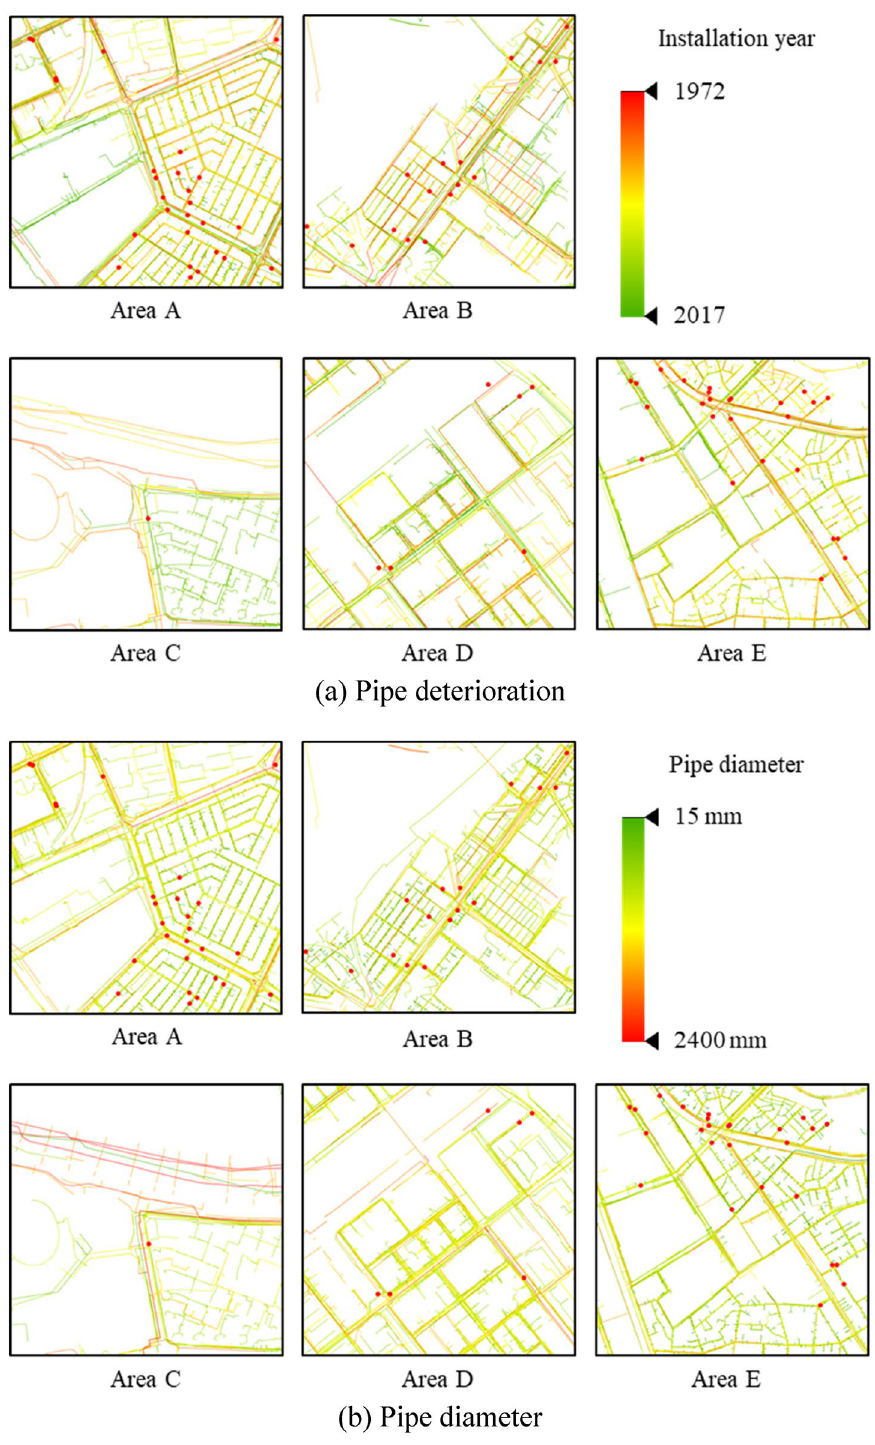
Figure 2. Ground sink conditioning